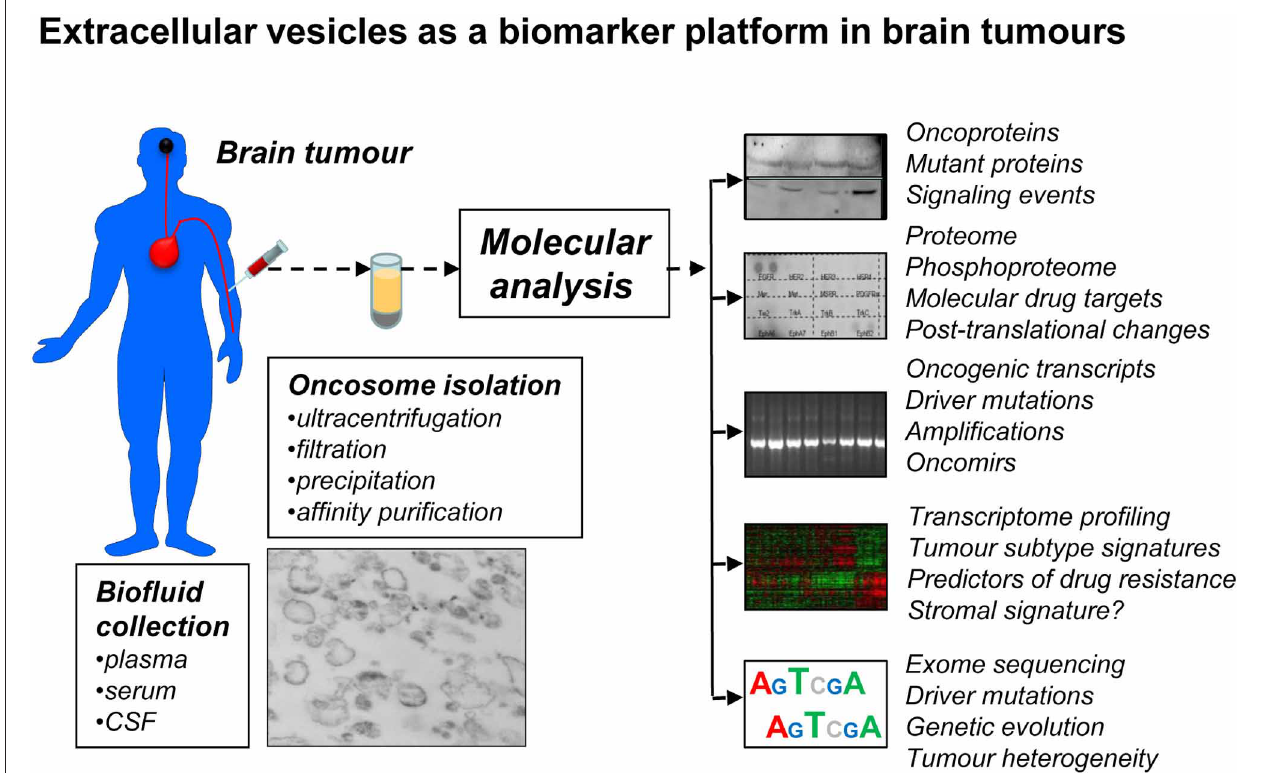
FIGURE 3 | Extracellular vesicles as a prospective biomarker platform in molecular diagnosis of primary and secondary brain tumors. EVs that circulate in peripheral blood or cerebrospinal fluid (CSF) can be readily recovered using several existing methods and various microfluidic and nanotechnologyplatforms under development. It may be possible to enrich for tumor-derived EVs (oncosomes) using tumor markers (EGFRvIII) and/or specific immunoaffinity techniques. The cargo of oncosomes may be dissected for individual molecules (oncoproteins), their activation, posttranslational processing (phosphorylation) and combinations, including